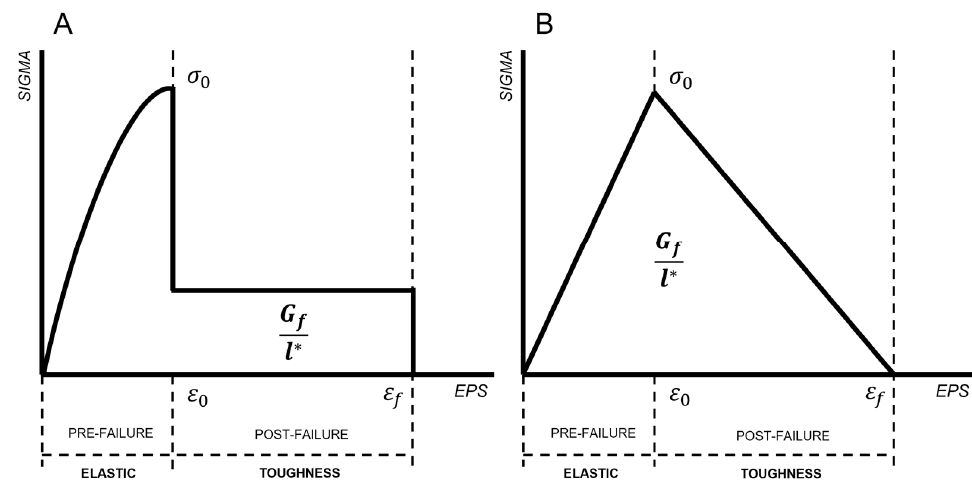
Figure 2. Main intralaminar composite material models currently implemented in LS-DYNA: ( A ) constant plateau model; ( B ) linear degradation model.